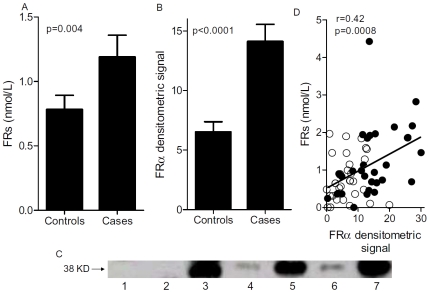
Patients with ovarian cancer have elevated levels of circulating FRα as compared to matched controls.Panel A shows the number of circulating folate receptor (FRs) extrapolated from the microfiltration assay assuming a 1∶1 molar ratio of FA∶FR in both the cases and matched controls Panel B shows the densitometric signal obtained using immunoblotting. P values in panels A and B are calculated using the Wilcoxon's matched pairs test and each bar represents the mean±s.e.m. Panel C: Lane 1, immunoprecipitation negative control; lane 2, negative control (MCF-7) lysate; lane 3, positive control (KB) lysate); lane 4, control serum sample; lane 5, matched ovarian cancer serum sample; lane 6, control serum sample; lane 7 matched ovarian cancer serum sample. Arrow = Mr 38000 protein; KD = kilodalton. Panel D shows the linear regression analysis correlating the microfiltration binding assay data and the immunoblotting data. Each data point represents a unique individual. Open symbols represent the healthy controls and closed symbols are patients.